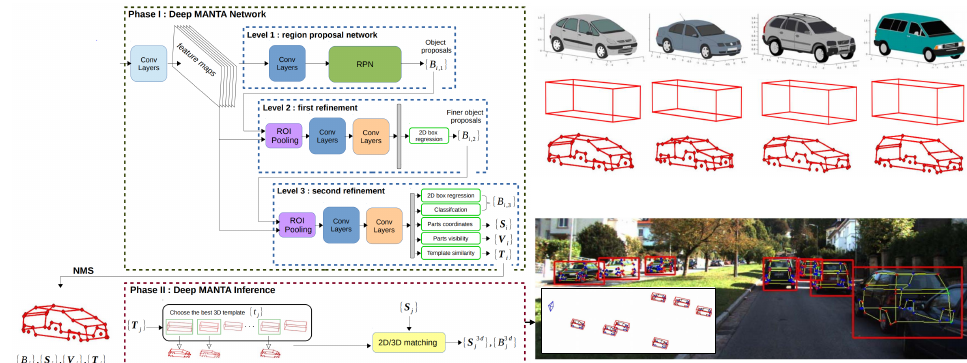
Figure 6. Overview of the deep MANTA approach [18].